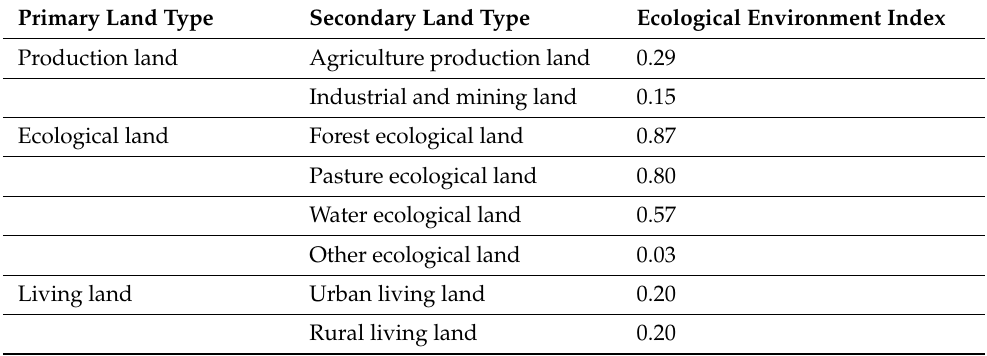
Table 1. Eco-environmental quality assignment for